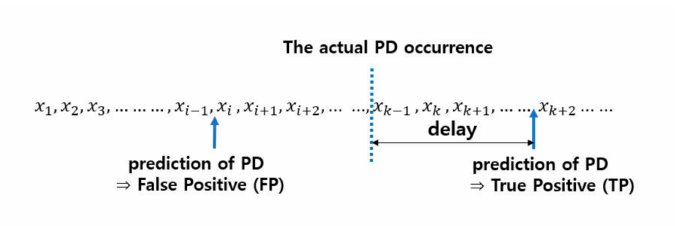
Figure 6. The illustration of performance evaluation measures [12].